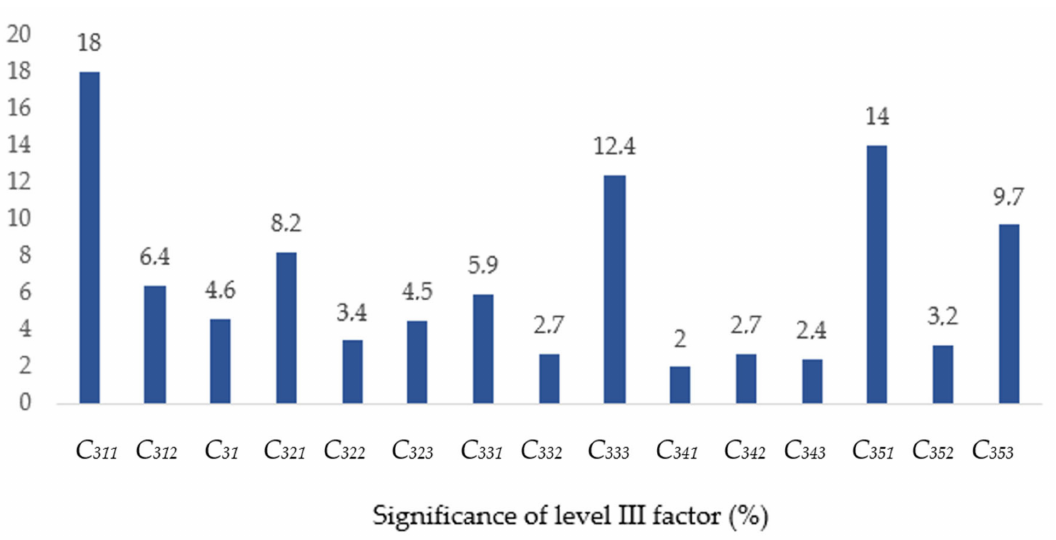
Figure 3. Assessment of the significance of level III factors (C 3 ) affecting the production of solar energy in small PV systems in Poland. Data on the diagram are presented ij percentage values. For each factor, system priority values were determined, which denoted their share in the hierarchy of significance of the main objective (C 1